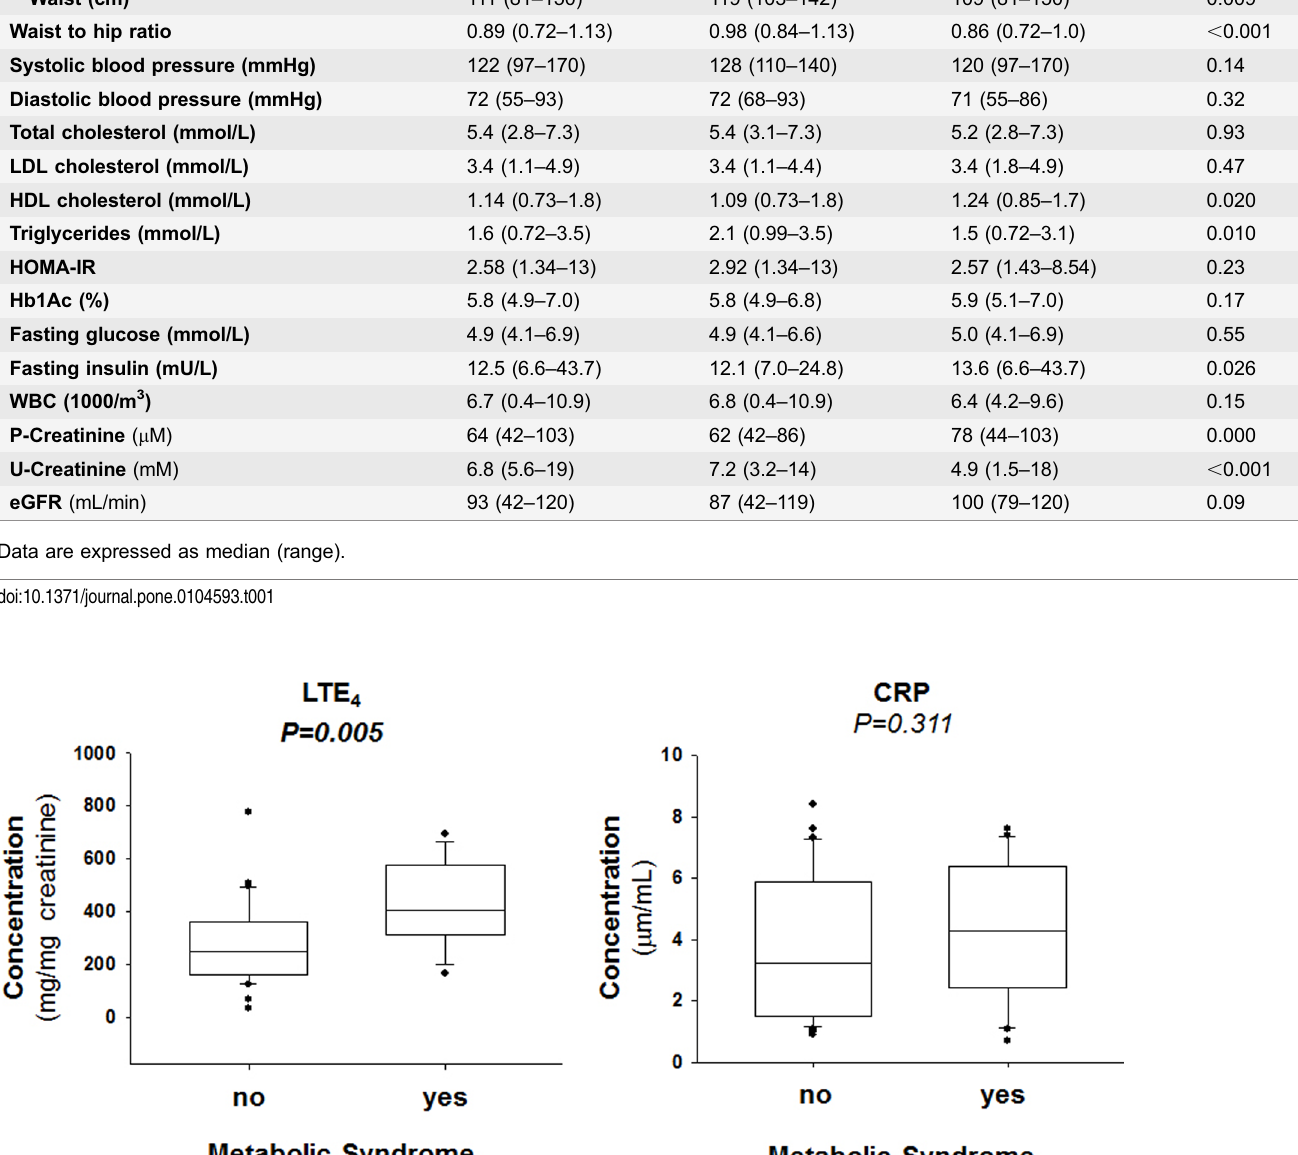
Table 1. Clinical and biochemical characteristics of the patient cohort (N 5 46) stratified according to sex. Characteristics